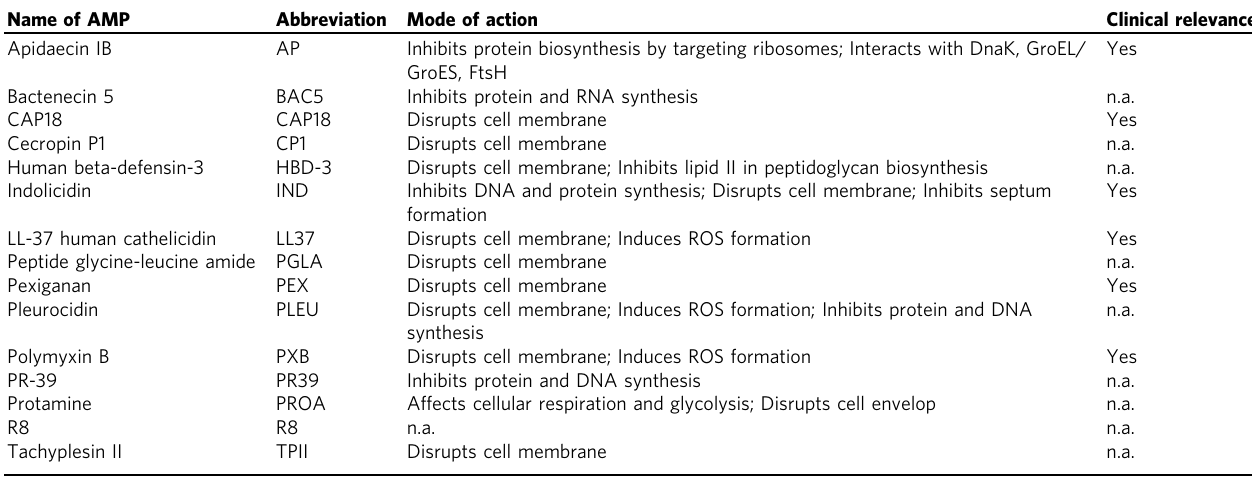
Table 1 List and characteristics of AMPs used in this study. Their abbreviation, described mode of action, and clinical relevance (for details see Supplementary Data